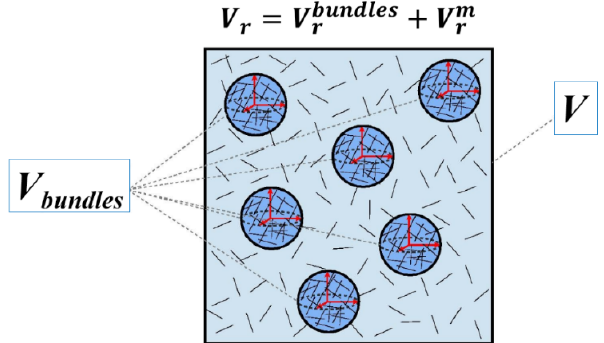
Figure 24. Sketch of volume element (RVE) with ellipsoidal bundles of carbon fillers [79].